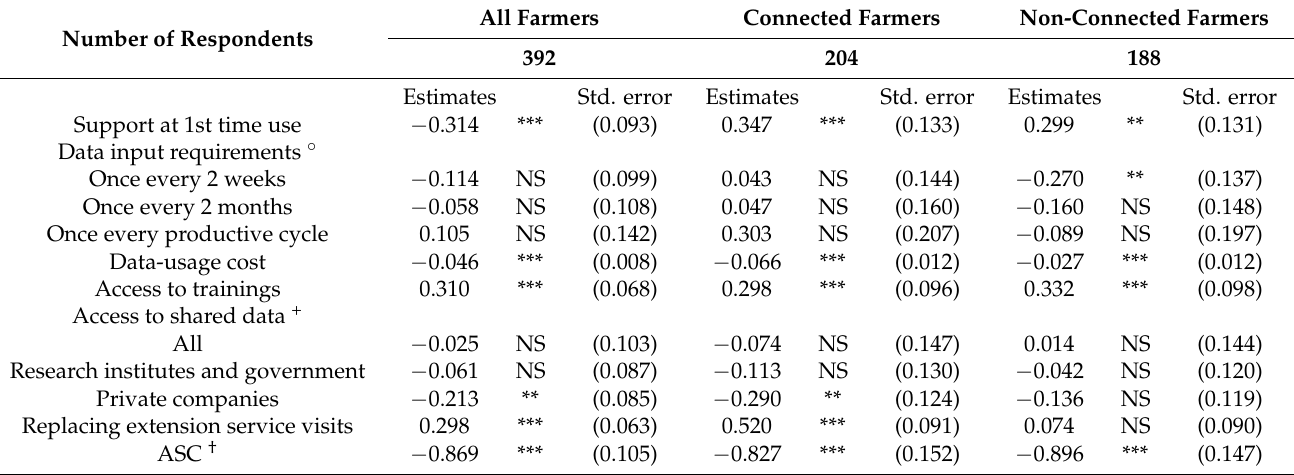
Table 3. Conditional logit model